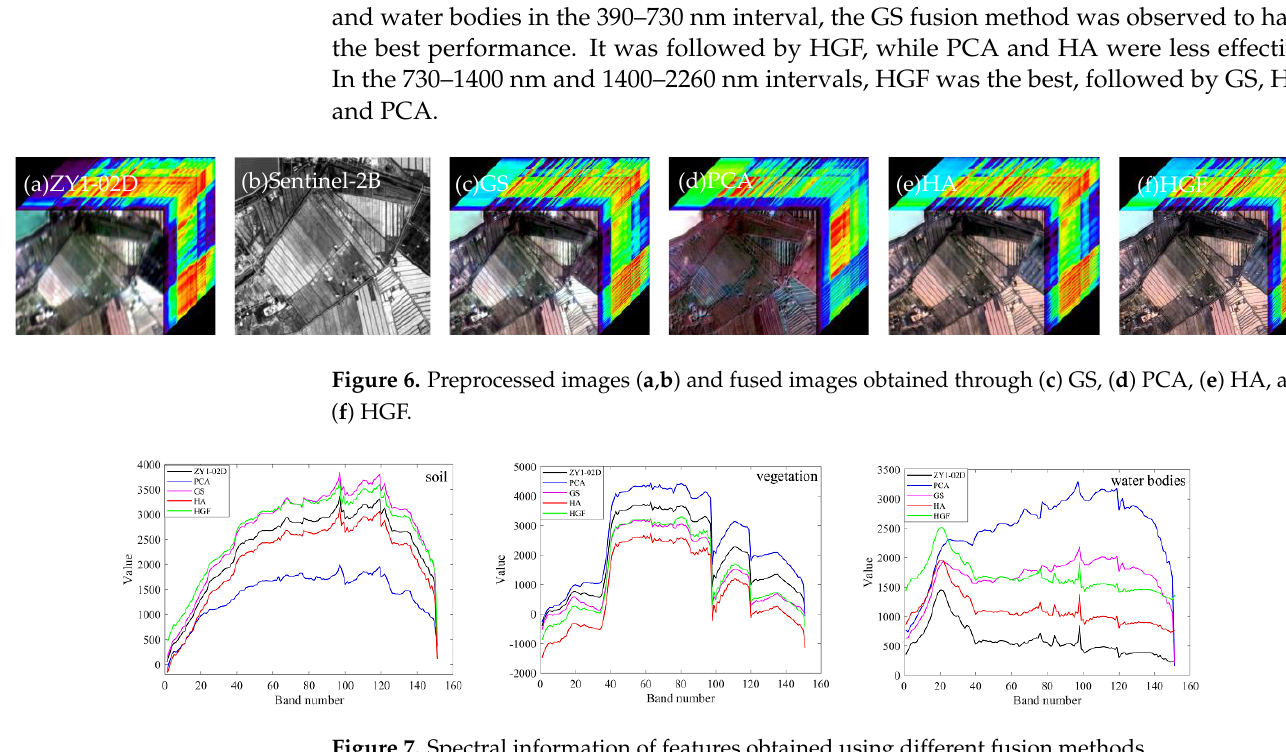
Figure 7. Spectral information of features obtained using different fusion methods. Table 3. Fusion accuracies.